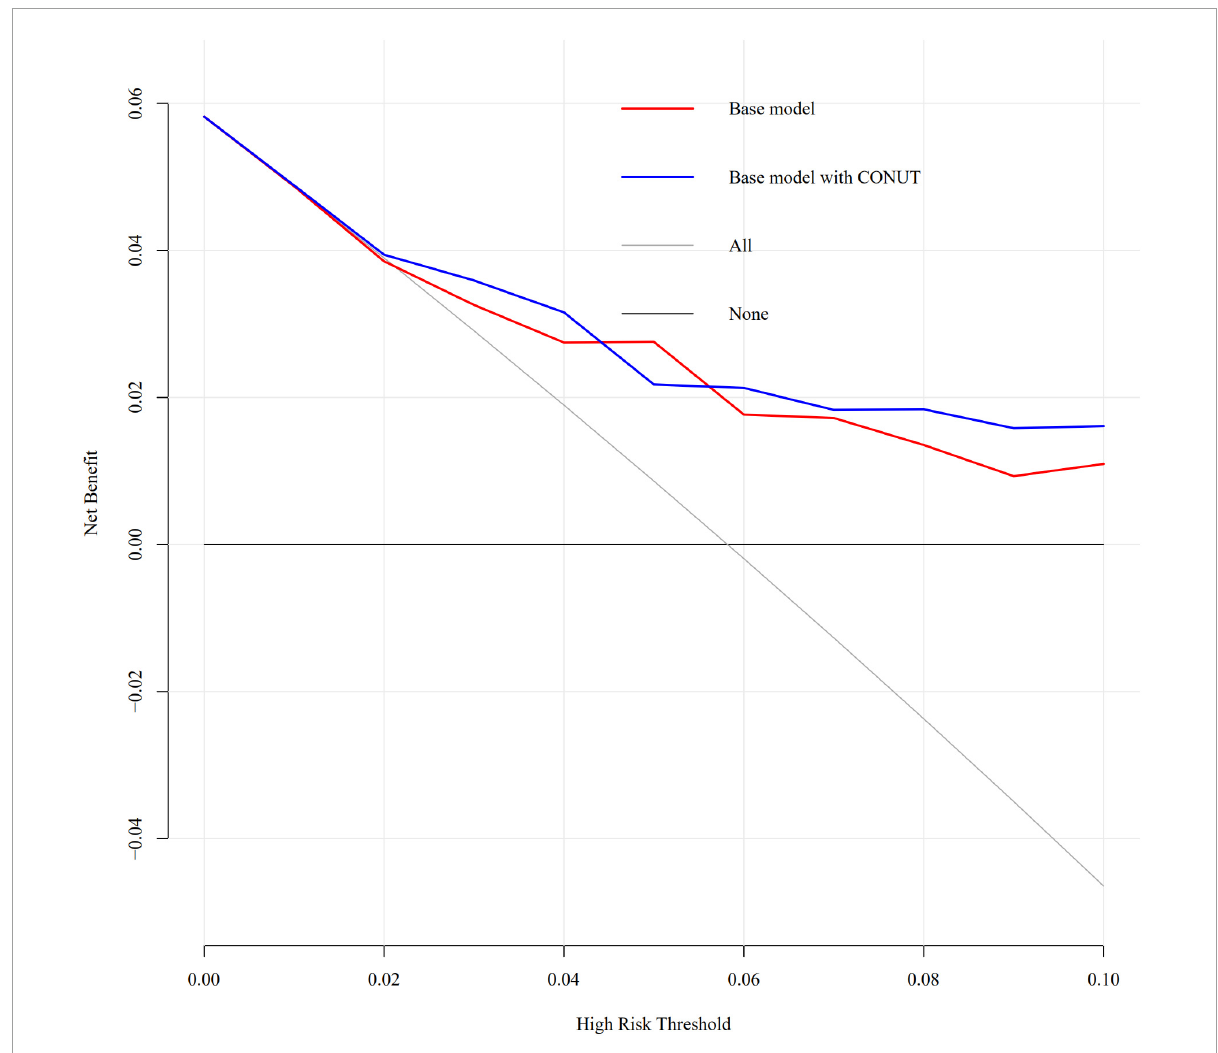
FIGURE2 Decision curve analysis of full model and model without